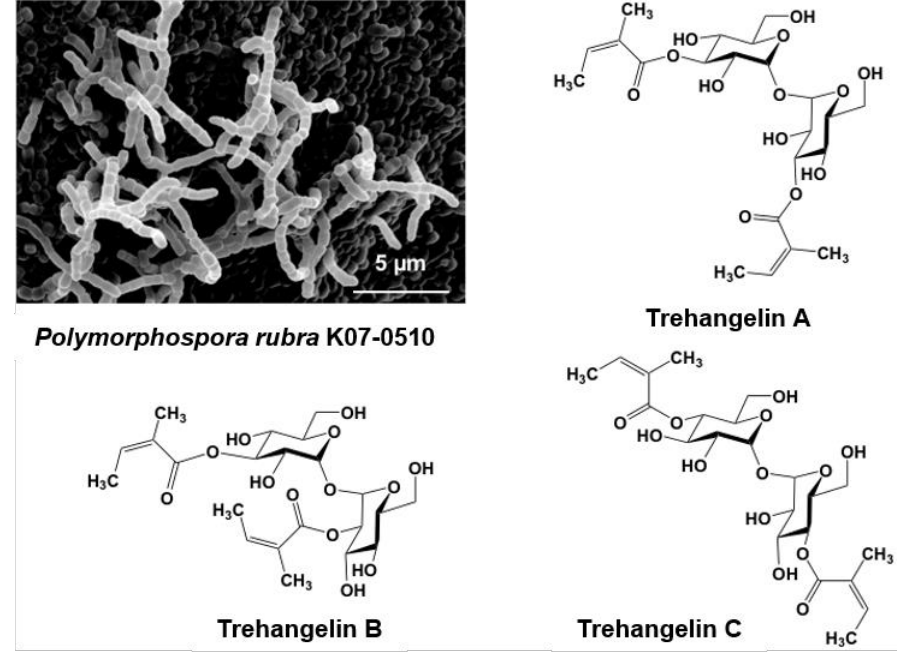
Figure 3. Scanning electron micrograph of the aerial spore chain of the trehangelin-producing strain Polymorphospora rubra K07-0510 and structures of trehangelin A, B, and